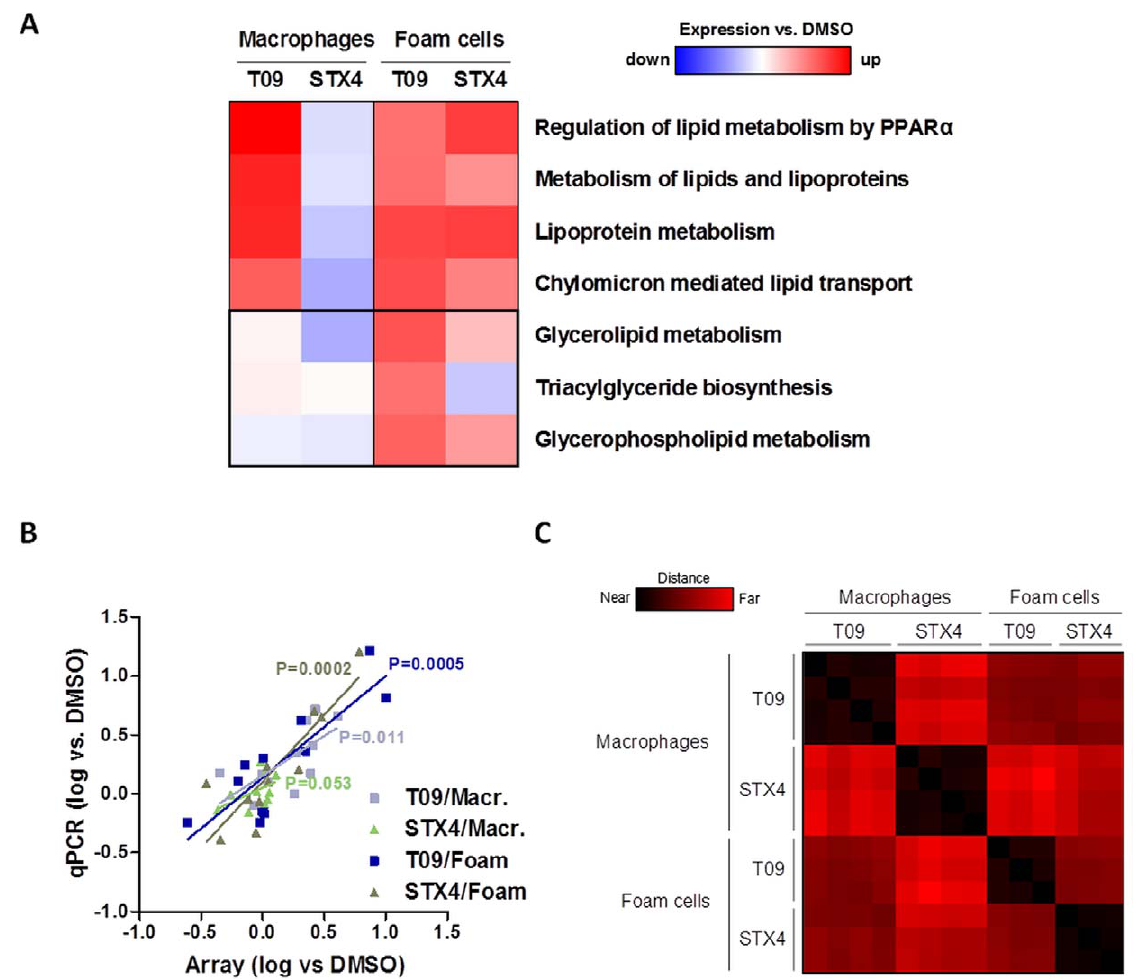
Figure 3. STX4 specifically regulates gene expression in foam cells. A , Genome-wide gene expression and subsequent gene set enrichment analysis (GSEA) of macrophages and foam cells after treatment with T09 (10 m M) or STX4 (10 m M). Regulation of lipid-derived Reactome and KEGG pathways is shown. B , Validation of gene expression microarray analysis by quantitative PCR. For all tested samples, array observations significantly correlated with qPCR results. C , Gene distance matrix of genome-wide gene expression analysis of macrophages and foam cells after treatment with DMSO (0.1%), T09 (10 m M) or STX4 (10 m M). Pairwise distances were calculated for comparison of two treatments and cell types. Colored squares show the distance in Euclidean space, ranging from exactly the same profile (black) to completely different (red). In macrophages STX4 expression is very different to that of T09 (P , 0.0001), whereas in foam cells STX4-induced gene expression is similar to that of T09 (P , 0.0001).